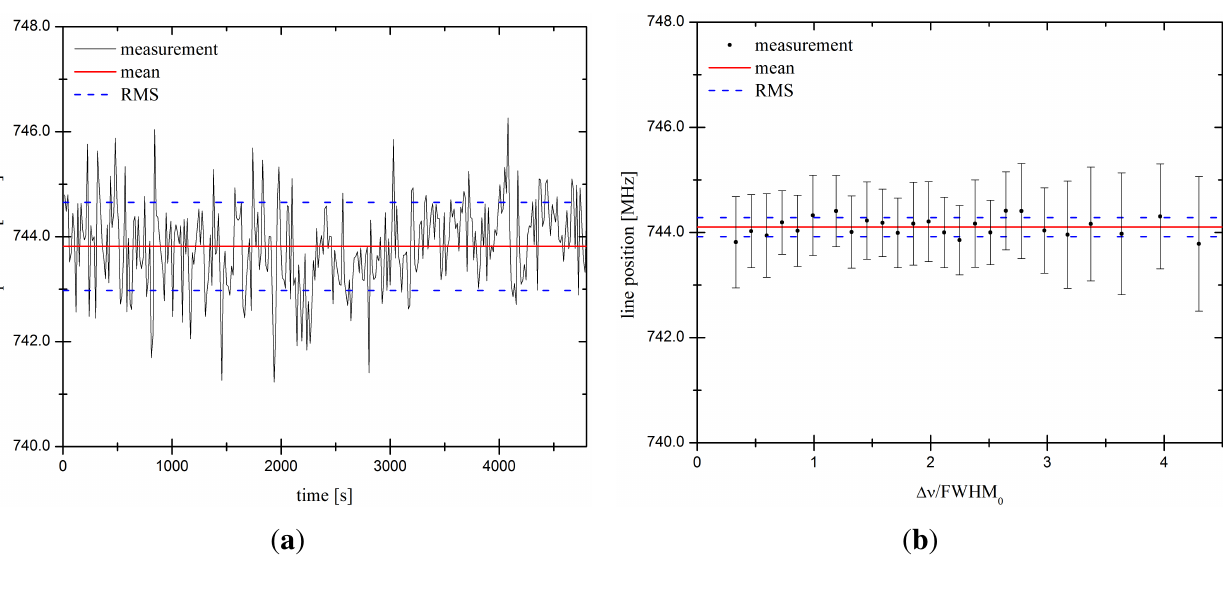
The red horizontal line represents the mean value and the blue dashed horizontal lines its RMS. ( a ) The center frequency is plotted vs . the observing time with a constant modulation bandwidth of ∆ ν = 0.33 FWHM . This measurement corresponds to the first data point in 0 ( b ); (b) The center frequency is plotted vs . the modulation bandwidth of a triangular wave modulation (TWM), normalized to the FWHM of the unmodulated 0